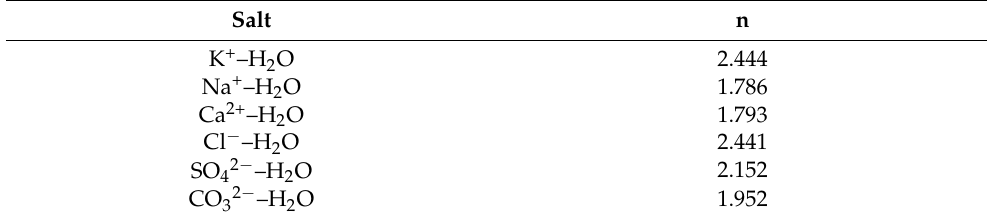
Table 5. Coordination number between ion and water.